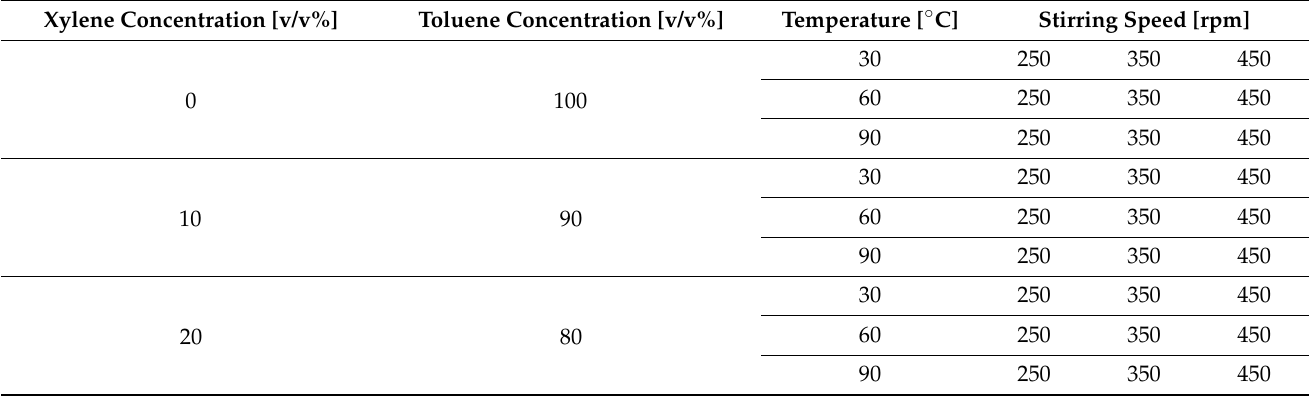
Table 1. Experiments performed for model